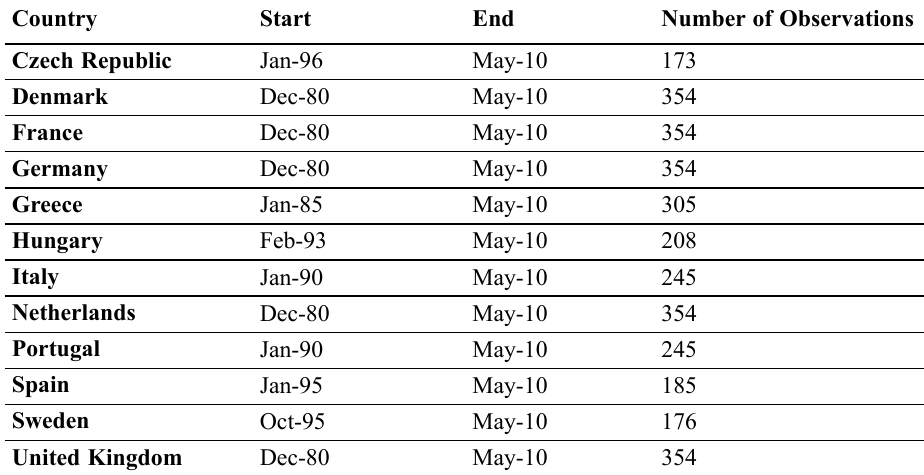
Table 2. Selected countries and time